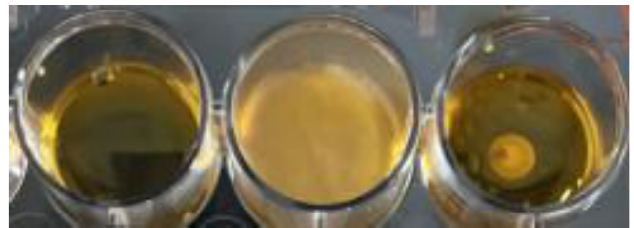
Figure 8. Antifungal activity of L. paracasei EPS DA-BACS. Left well, yeast malt soft agar without inoculation as the blank; middle well, yeast malt soft agar inoculated with A. brasiliensis followed by incubation at 25 °C for 48 h; right well, L. paracasei EPS DA-BACS culture was inoculated at the center of a well and incubated for 24 h at 37 °C, and A. brasiliensis was inoculated and incubated at 25 °C for 48 h.